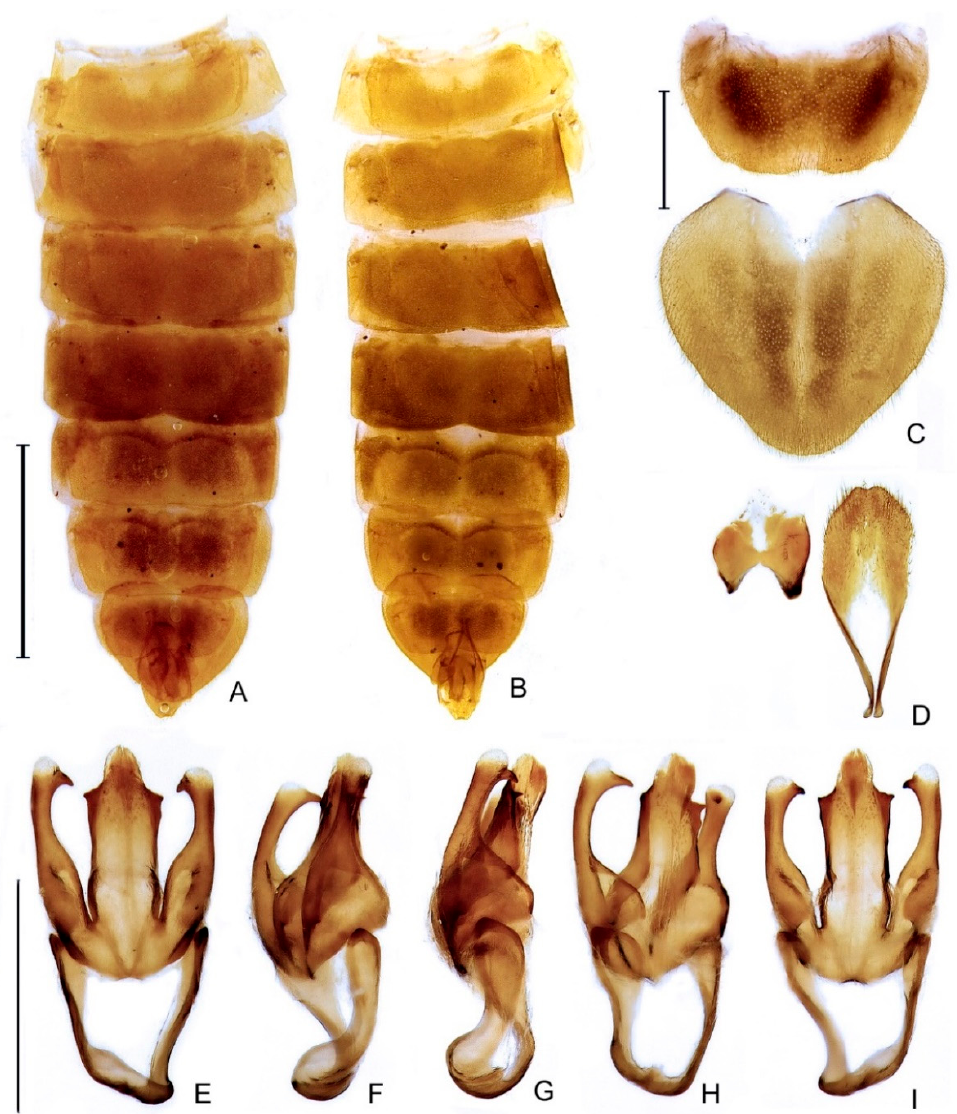
( N ) Pro-, meso-, and metaleg, from top to bottom, respectively. ( O ) Pro-, meso- and metatarsus, from left to right, ventral. Scale bar: A–K: 2 mm.